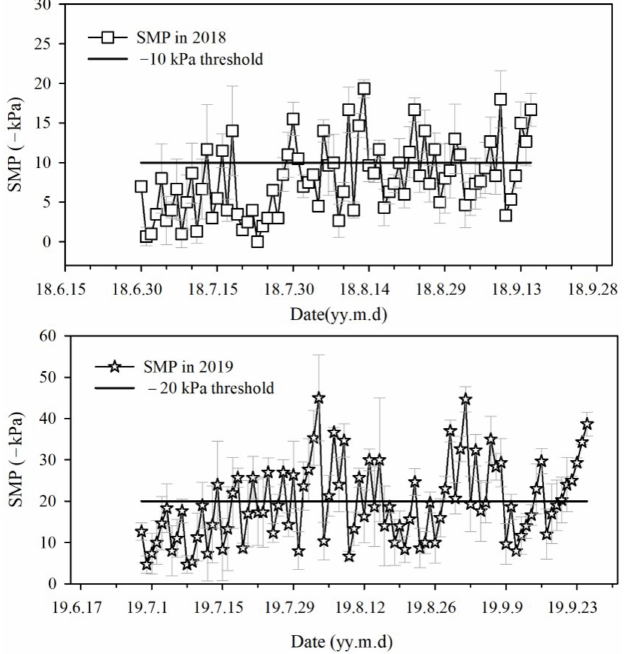
Figure 2. Daily soil matric potential (SMP) dynamics in the 2018 and 2019 growing